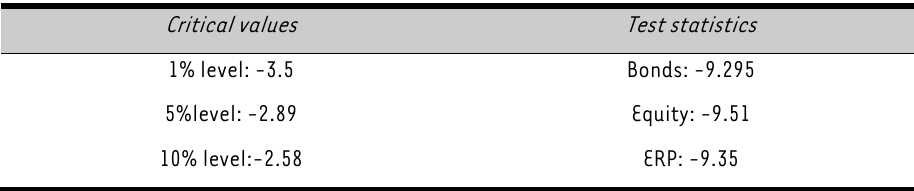
TABLE 4: Stationarity of bond, equity returns and ERP: results of augmented dickey-fuller